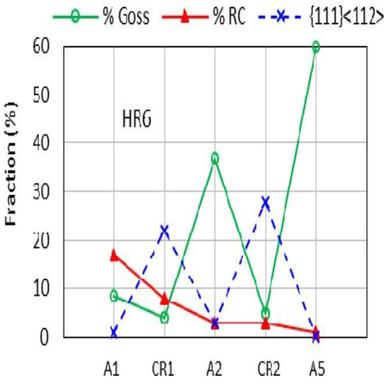
Evolution of the main texture components during the thermo-mechanical processing of the hot-rolled sheet (a) HR1 and (b) HR6.